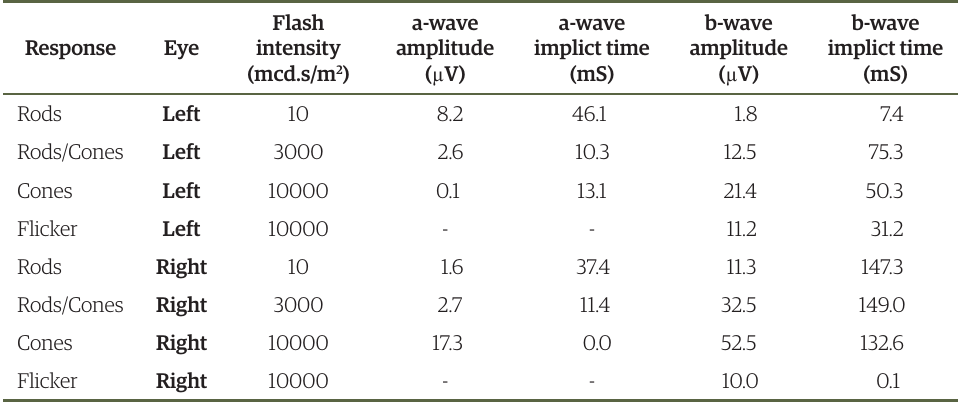
Table 3. Electroretinographic response of a 4-month-old female horse (case 2) of the breed Mangalarga Marchador presenting with congenital night